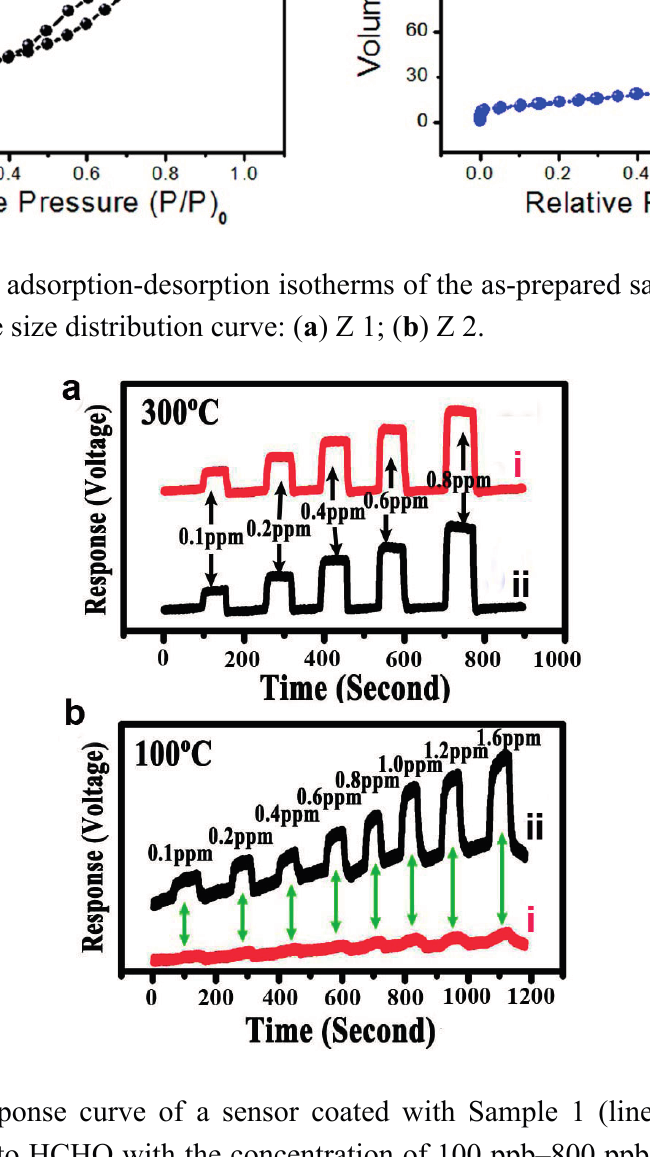
Figure 5. ( a ) Response curve of a sensor coated with Sample 1 (line i) and Sample 2 (line ii) at 300 °C to HCHO with the concentration of 100 ppb–800 ppb, when the HCHO gas was repeatedly introduced into the measurement system and then shut down; ( b ) Response curve of a sensor coated with Sample 1 (line i) and Sample 2 (line ii) at 100 °C to HCHO with the concentration of 100 ppb–1600